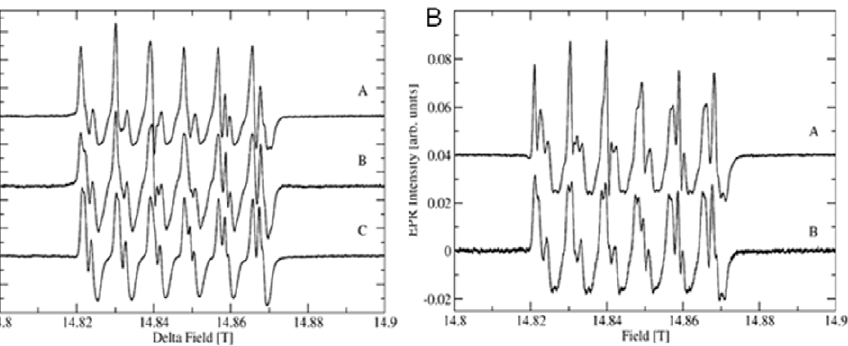
Figure 8. pH dependence of recombinant, wild-type CsOxOx and A242E CsOxOx mutant at 416.0 GHz. 8A: Recombinant, wild type CsOxOx A: Same sample as C after the addition of 100 mM glycine buffer, pH 3.0. B: Same sample as C after the addition of 100 mM acetate buffer, pH 4.0. C: in 25 mM Imidazole-Cl, pH 7.0. 8B: A242E CsOxOx mutant. A: Same sample as B after the addition of 100 mM acetate buffer, pH 4.0, B: in 25 mM Imidazole-Cl, pH